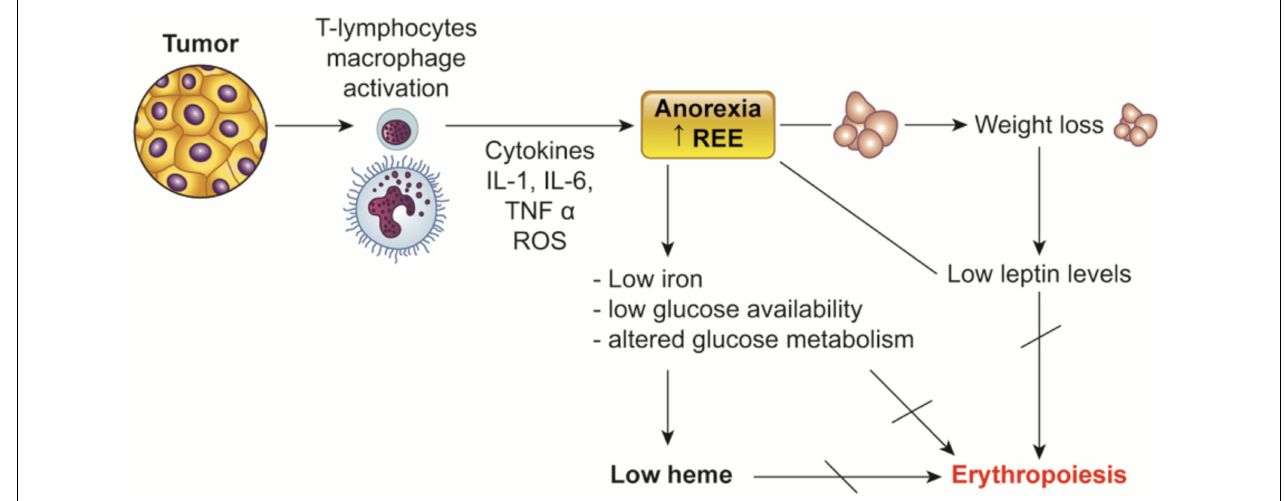
FIGURE 2 | Relationship between nutritional status, leptina and cancer-related anemia. Impaired energy metabolism and low nutrients availability induced by cancer-associated chronic inflammation are involved in the impairment of erythropoiesis. Low iron as well as low heme synthesis as a consequence of altered efficiency of glucose metabolism impair erythropoiesis. Leptin, which decreases as a consequence of such metabolic/nutritional changes, can also influence erythropoiesis by itself. REE, resting energy